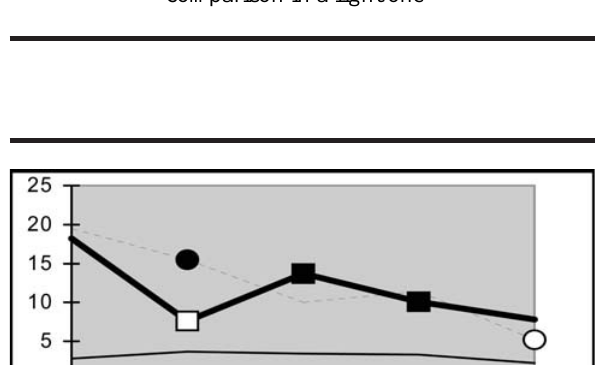
FIGURE 9 - Vascular volume. Comparison between subgroups (7, 30, 60, 90, 180 days) of each group separately. The significant value is indicated with a dark line and its comparison in a light one